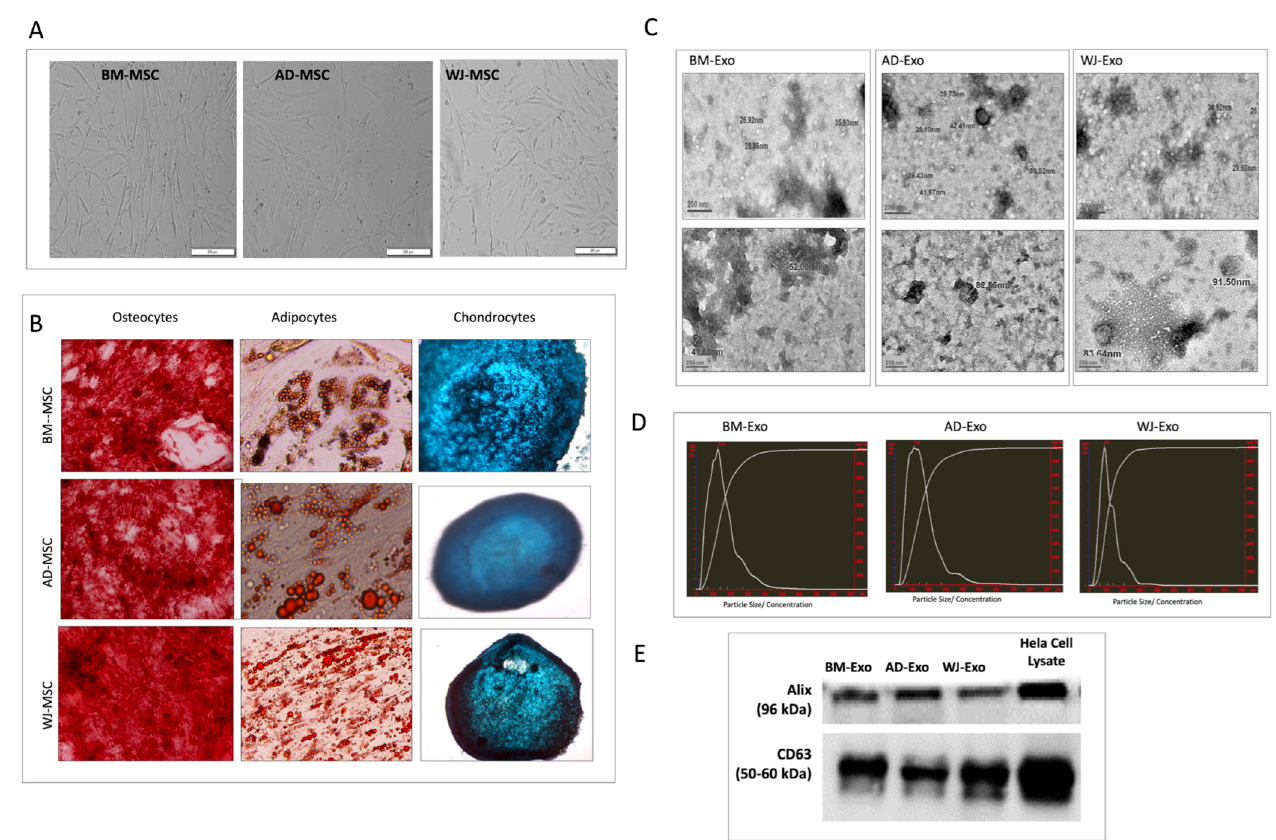
Figure 1. Characterization of hMSCs and their exosomes. ( A ) Phase-contrast microscopy of tissue-specific hMSCs (magnification 10 × ) (upper panel). ( B ) Trilineage staining of hMSCs: Alizarin Red staining for osteocytes’ differentiation, oil red O staining for Adipocytes’ differentiation, and alcian blue staining for chondrocytes’ differentiation (magnification 20×) (lower panel). ( C ) Morphology analysis of exosomes by Transmission Electron Microscope (TEM) (Bar = 200 nm; 19 KX) (right panel). ( D ) Exosomal size distribution analysis using nanoparticle tracking analysis (NTA). ( E ) Western blots showing expression of exosomal surface marker CD63 and ALIX.